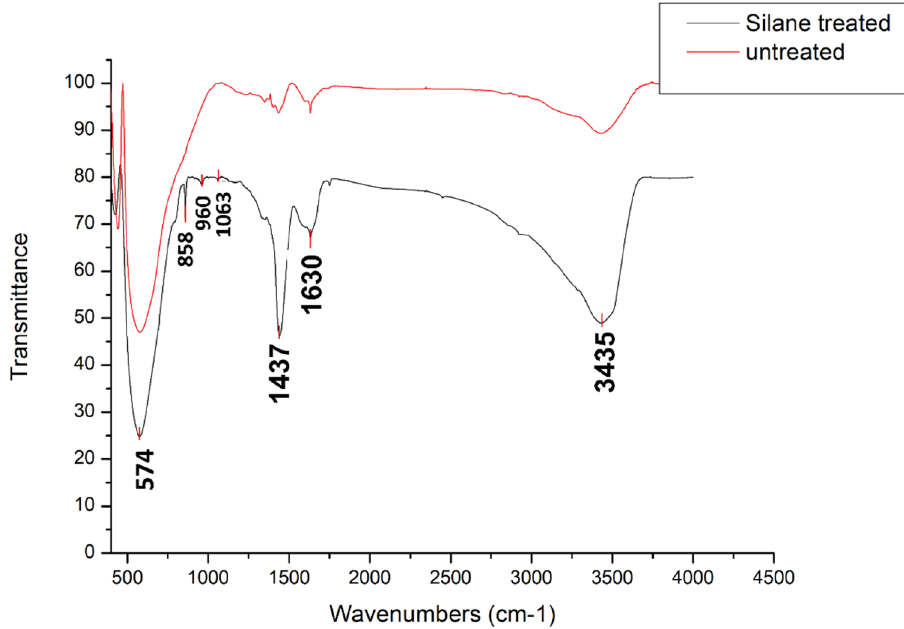
Figure 8. FTIR spectra of Si-BaTiO 3 (black) and untreated (red) BaTiO 3 powders.